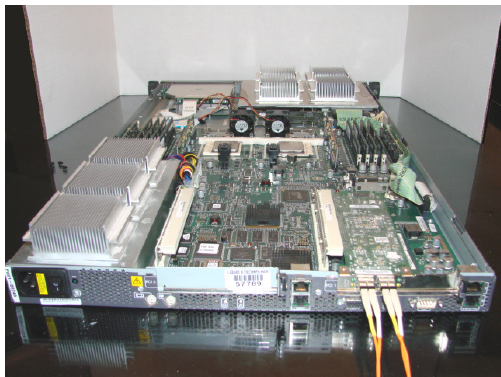
Figure 3. Photograph of the DAS system. This system drives four fiber optic cables.